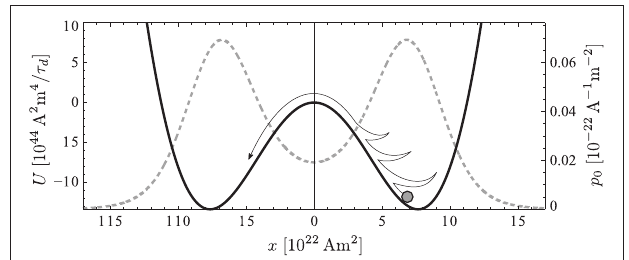
FIGURE 1 | Drift potential U ( x ) (solid curve, left axis) and steady-state probability density function p 0 ( x ) (dashed curve, right axis) for the “particle-in-well” analog to reversing dynamos. The potential forces provide the deterministic slow drift while fast stochastic fluctuations enable the particle to cross the potential barrier that separates both polarities. p 0 is the analytical solution of the stationary Fokker-Planck equation (Equation 27). The reversing dynamo model shown is E3R9. After Figure 2 in Schmitt et al. (2001).